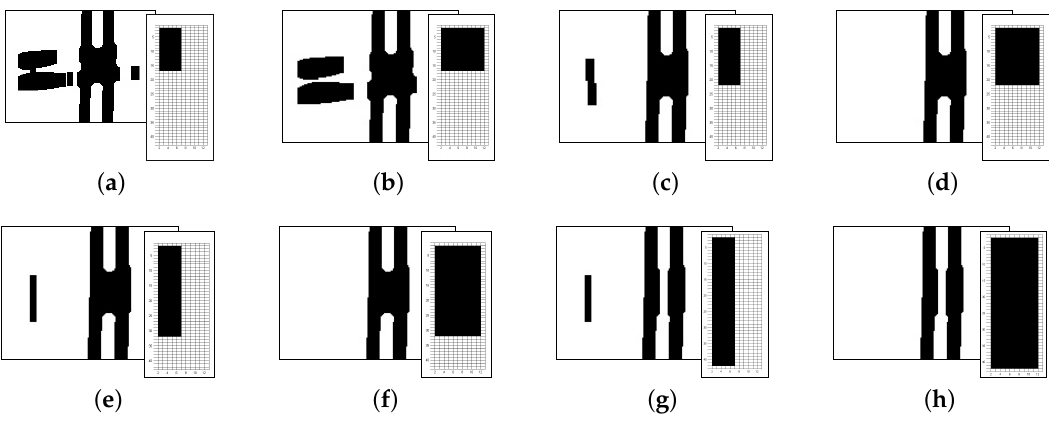
Figure 19. The effect of increasing the size of the rectangular kernel. ( a ) size 15 × 05; ( b ) size 15 × 10; ( c ) size 20 × 05; ( d ) size 20 × 10; ( e ) size 30 × 05; ( f ) size 30 × 10; ( g ) size 40 × 05; ( h ) size 40 × 10.